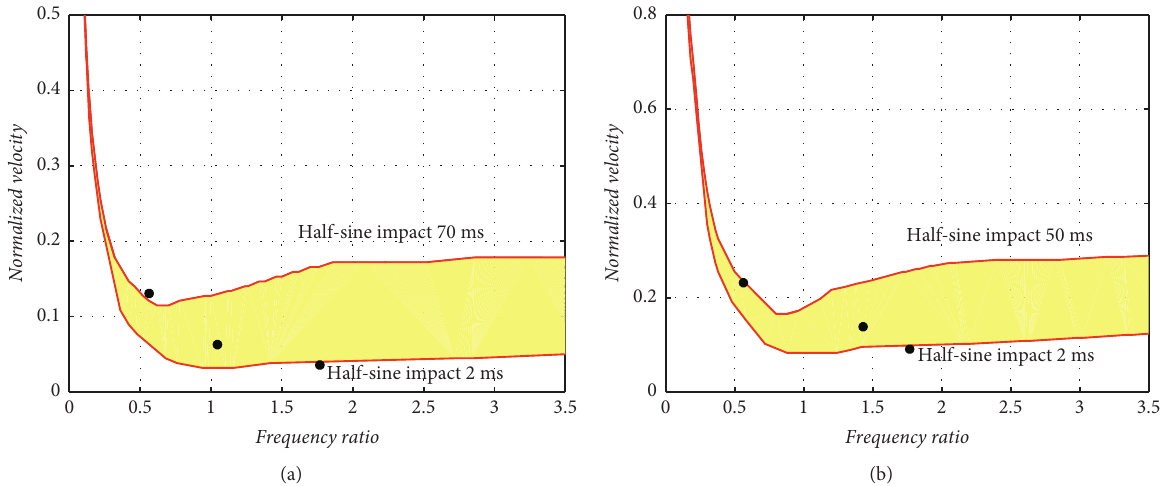
Figure 10: DDBCs of a packaging system with cubic stiffness under half-sine pulses for different durations. (a) 2 g . (b) 5 g .